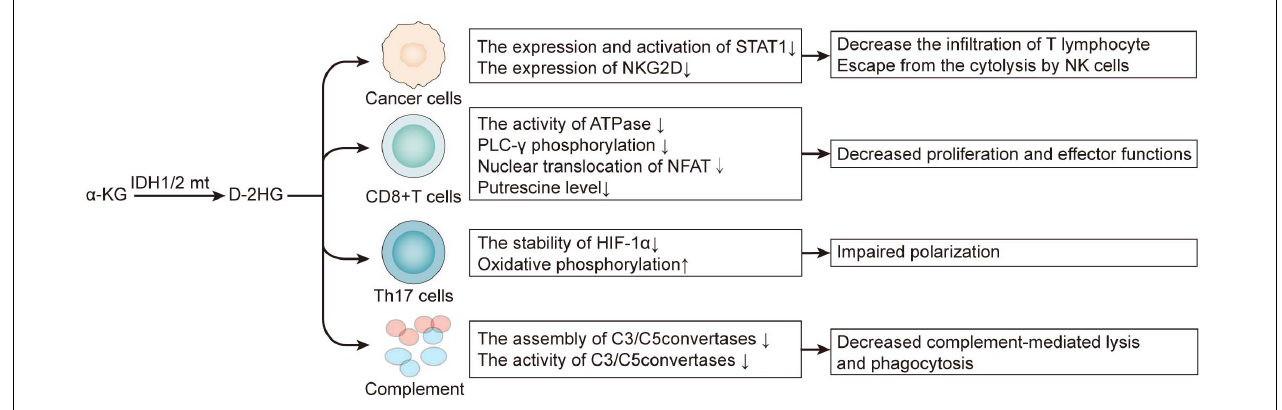
FIGURE 2 | D -2HG derived from mutant IDH is an immunosuppressive metabolite. 2-HG,